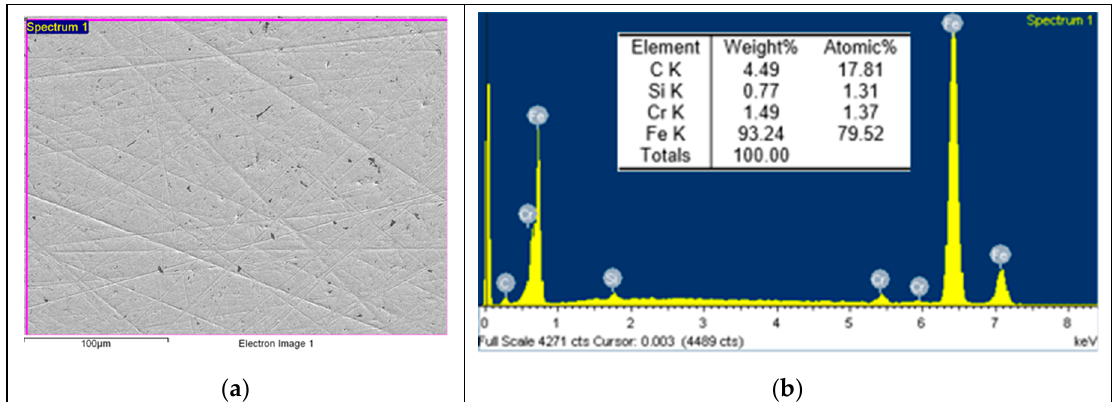
Figure 6. ( a ) SEM image and ( b ) EDS spectrum for non-tested discs.